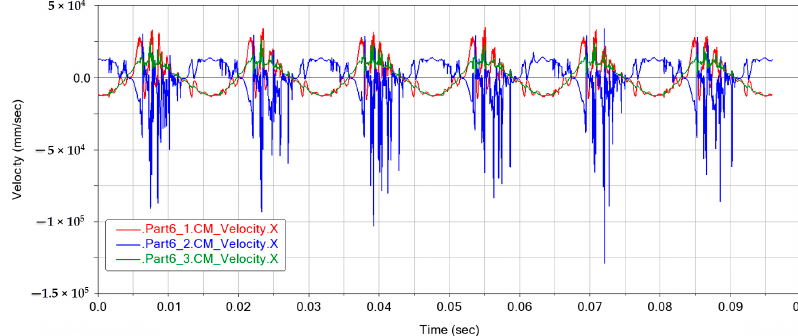
Figure 13. Engine piston speed curve.